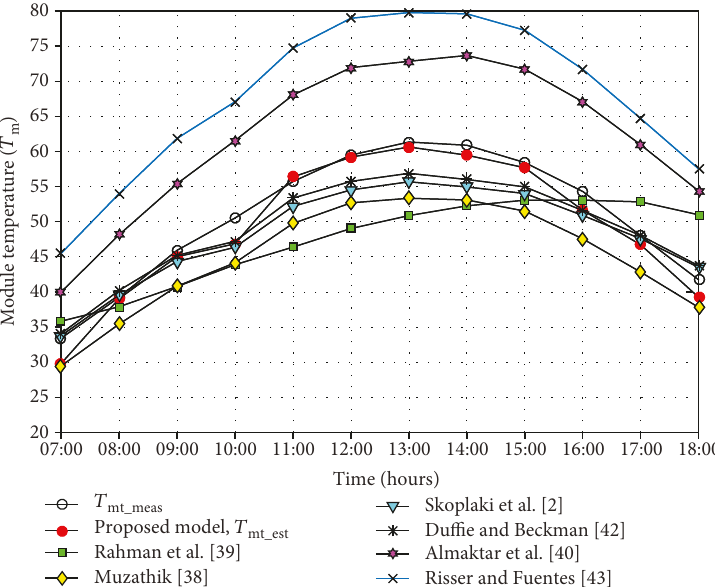
Figure 15: Proposed model estimation versus measured data and other existing model module temperature values of thin fi lm module during